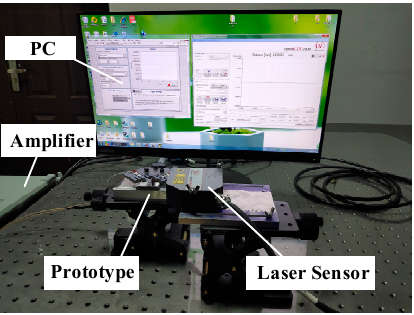
Figure 16. Experimental system for testing the output performances of the designed piezoelectric actuator.